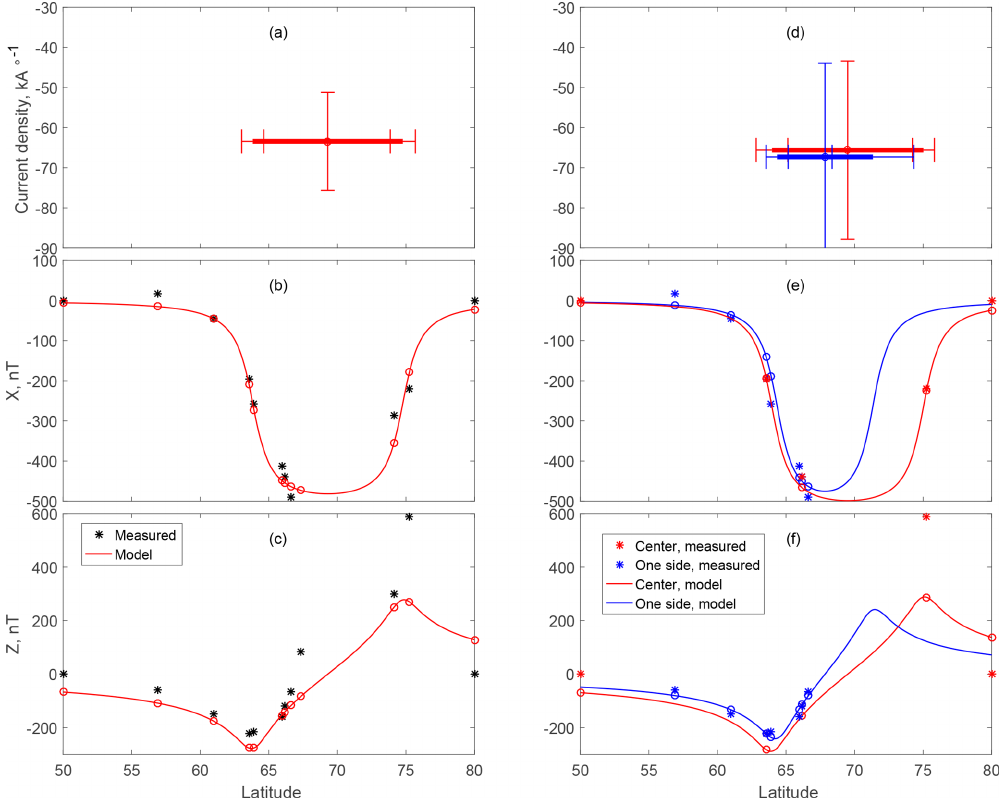
Figure 5. Event on 24 November 1996 at 23:09:00UT. Effect of the station selection. Panels (a, b, c) show many stations covering both boundaries of the electrojet. Panels (d, e, f) show a small number of stations on both sides of the electrojet (red) and near only one boundary (blue). The error bars (standard deviation) are shown using the thin lines in panels (a) and (d)